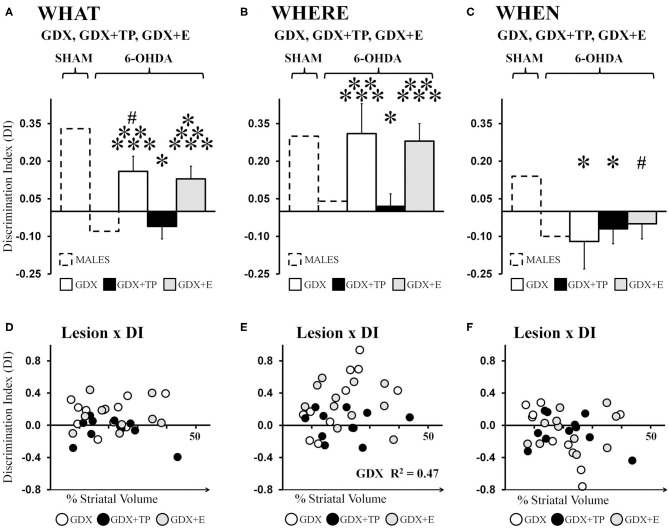
Bar graphs showing average “What” (A), “Where” (B), and “When” (C) discrimination indices (DIs) calculated from object exploration in Test Trials for 6-hydroxydopamine (6-OHDA) lesioned male rats that were gonadectomized (GDX, white), that were GDX and supplemented with testosterone propionate (black), or GDX and supplemented with 17β-estradiol 6-OHDA (gray); data from gonadally intact SHAM and 6-OHDA lesioned MALES are shown for reference (dashed outline). The GDX+TP cohort was profoundly impaired for “What” (A), “Where” (B), and “When”(C) discriminations. In contrast, DI's for the GDX and GDX+E groups were moderate for “What,” robust for “Where,” and poor for “When.” Results from allowed post-hoc comparisons of DI that included all of the male groups are shown as follows: significantly different than MALE SHAM (*); near significantly different than MALE SHAM (#); significantly different than MALE 6-OHDA (**); significantly different than GDX+TP 6-OHDA groups (***).Scatter plots below of “What” (D), “Where” (E), and “When” (F) DIs as functions of the size (percent of total striatal volume) of 6-OHDA lesions for individual GDX (white circles), GDX+TP (black circles), and GDX+E (gray circles) 6-OHDA rats show no consistent relationships between the two for “What” or “When” DI. For “Where” DI, a significant positive correlation was found between larger lesions and better “Where” DI for GDX 6-OHDA rats; the R2-value is shown on the plot (E).